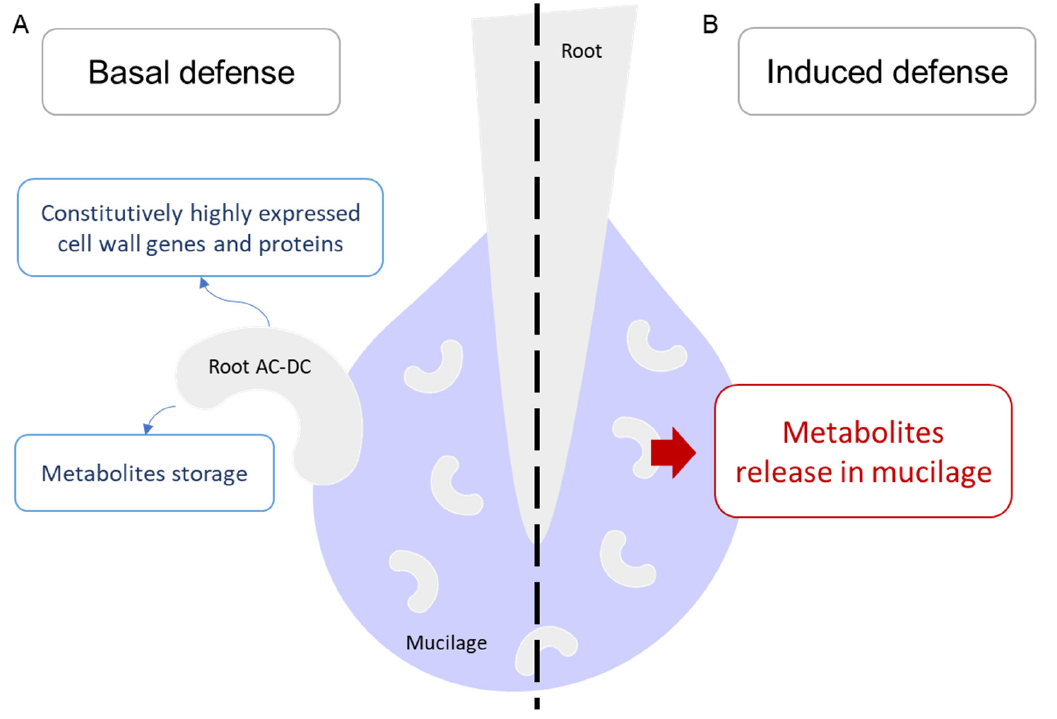
Figure 7. Overview of root AC-DC basal and induced defense responses. ( A ) In root AC-DC, constitutive differences with roots mainly consist of highly expressed cell wall genes and proteins and metabolite storage. ( B ): Upon PEP-13 elicitation, a transfer of metabolites was observed from root AC-DC to the mucilage.